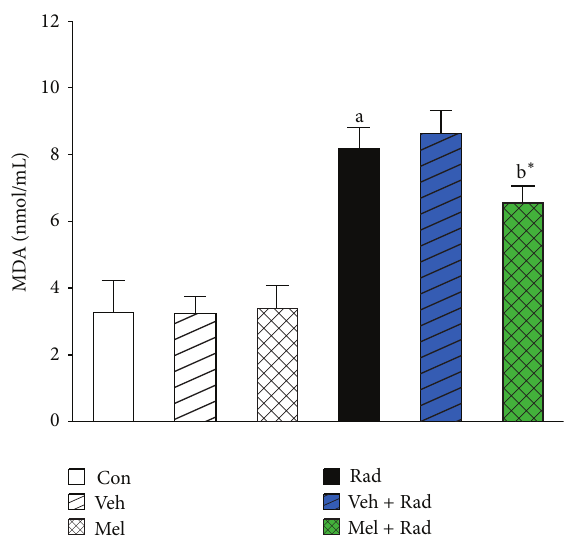
Figure 4: The effect of melatonin on MDA levels in rats subjected to whole body gamma irradiation. Data represent mean ± standard error on the mean (SEM) for 5 animals per group. Con: Control group, Veh: Vehicle only group, Mel: Melatonin only group, Rad: Radiation only group, Veh + Rad: Treated with vehicle and exposed to10 Gyradiation,andMel+Rad:Treatedwith100 mg/kgmelatonin before exposure to 10 Gy radiation. a 𝑃 < 0.001 when compared to ∗ 𝑃 < 0.01 when compared to the radiation only Control group. b